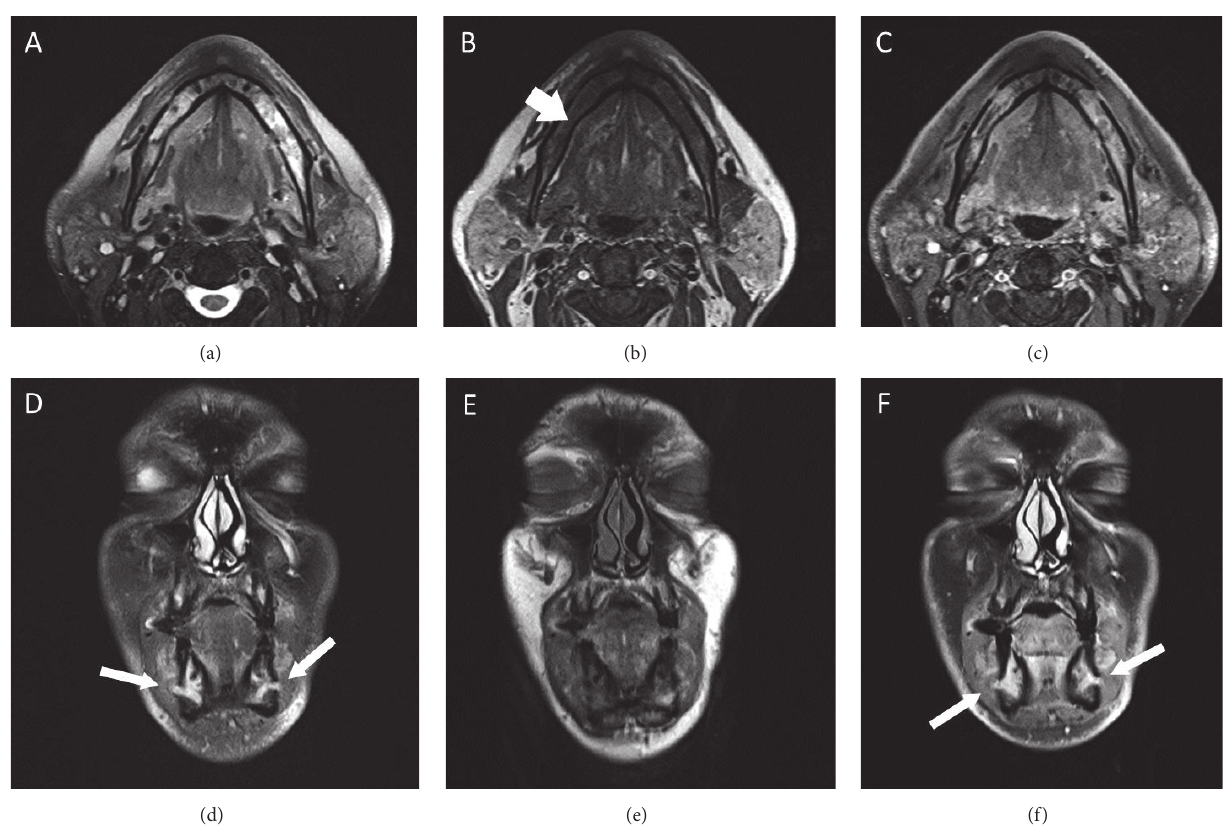
Figure 4: Axial MRI images at the level of the mandible demonstrating abnormal bone marrow infiltrative process replacing the normal bone signal on both T2-weighted images (a) and T1-weighted images (b) with diffuse enhancement on the contrast-enhanced axial T1-weighted images (c) (short arrows). There were no pathologic fractures and no soft tissue masses. Coronal T2-weighted images (d), unenhanced T1- weighted images (e), and contrast-enhanced T1-weighted images (f), showing abnormal thickening and enhancement of the mental nerves as they exit the mental foramen bilaterally (long arrows).